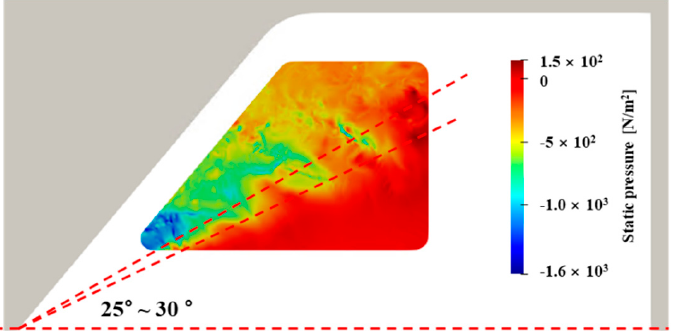
Figure 8. Snapshot of iso-contours of surface wall pressure on left window with reattachment line (at t = 2.8 s).